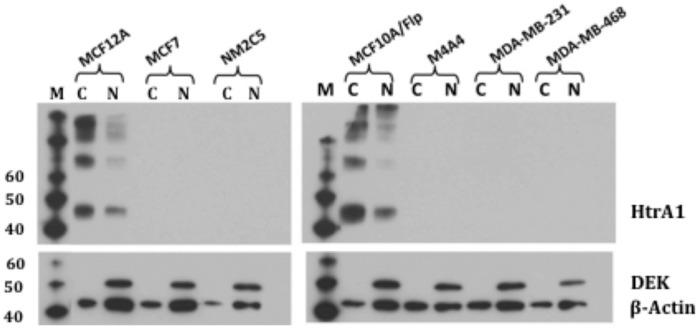
HtrA1 Protein Expression in hBC cell lines.Cells (as indicated) were extracted into nuclear (N) and cytoplasmic (C) fractions as described (Materials & Methods), and proteins were analyzed by Immunoblot analyses using the polyclonal antibody against human HtrA1. β-actin was used as a loading control, and DEK was used to assess the nuclear/cytoplasmic fractionation (DEK is exclusively nuclear). The larger Mr bands seen in the MCF12A and MCF10A/Flp cell lines are consistent with dimers, trimers, etc., although this was not confirmed. MCF10A/Flp is the parental Flp-in cell line which was used to produce the various MCF10A/siRNA or Htra1 cell lines. Results are from a representative experiment.